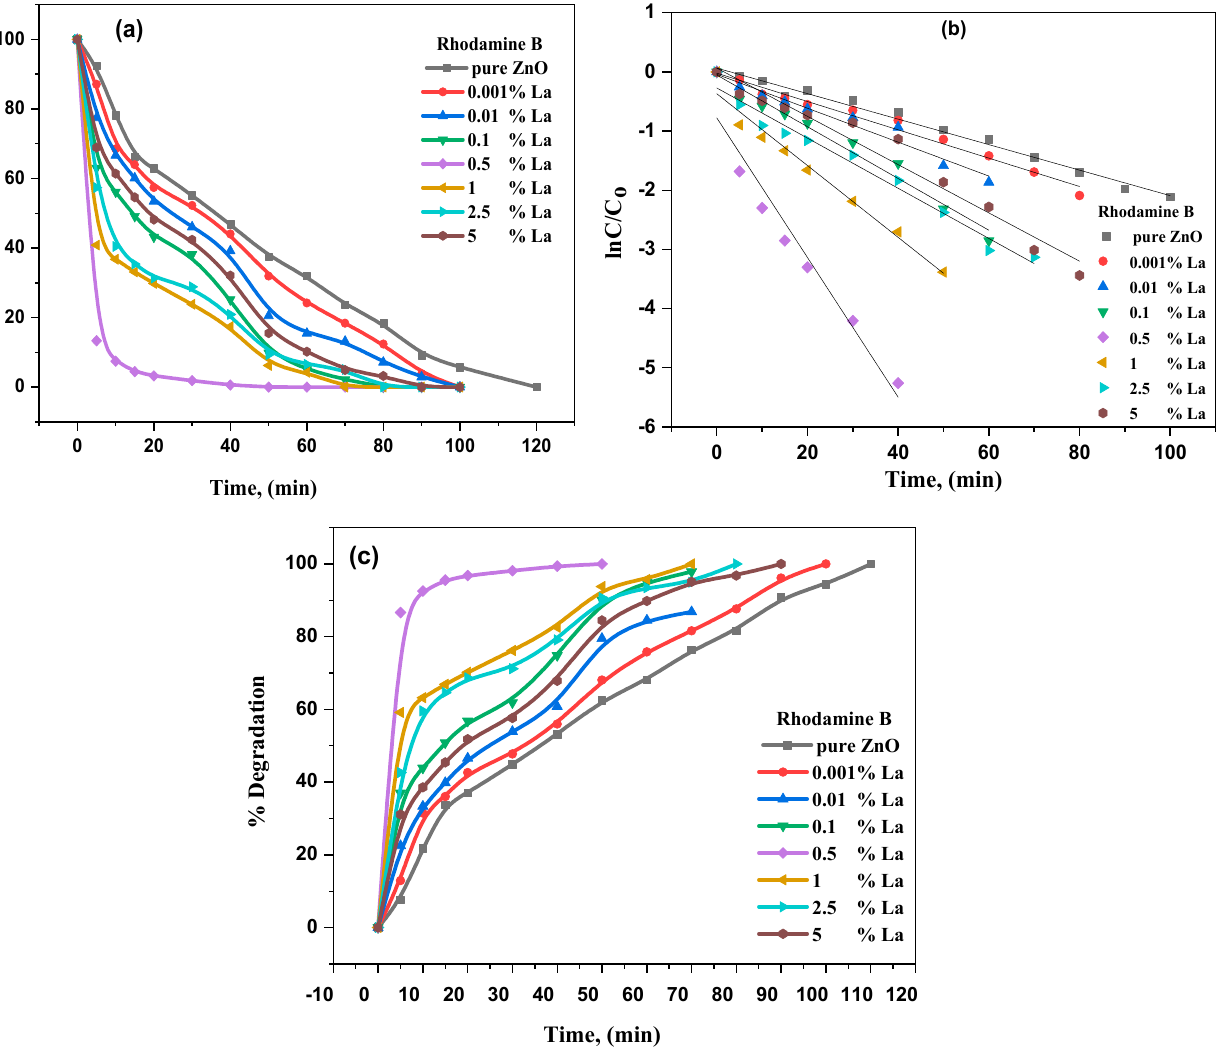
Figure 10. ( a – c ): photodegradation of RhB in the presence of pure ZnO and La 2 O 3 -ZnO nanostruc- tured composites, ( a ) concentration of RhB with time, ( b ) kinetic study of photodegradation of RhB, ( c ) percentage degradation of RhB versus time.